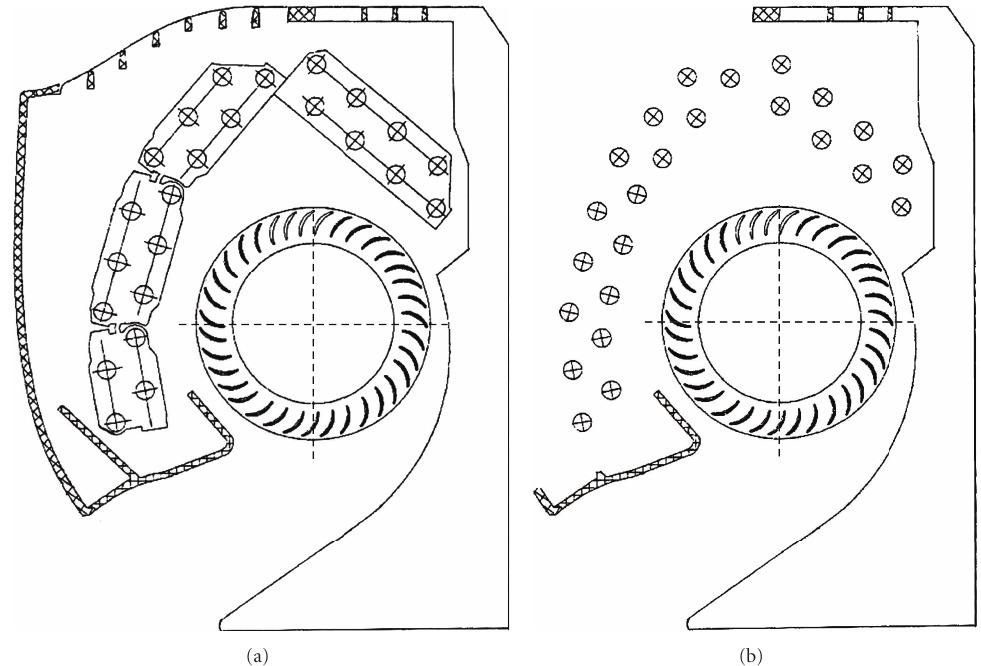
Figure 3: Geometry of the cross-flow fan from a split-type air-conditioner. (a) With air-return grill and heat exchanger. (b) Without air- return grill and heat